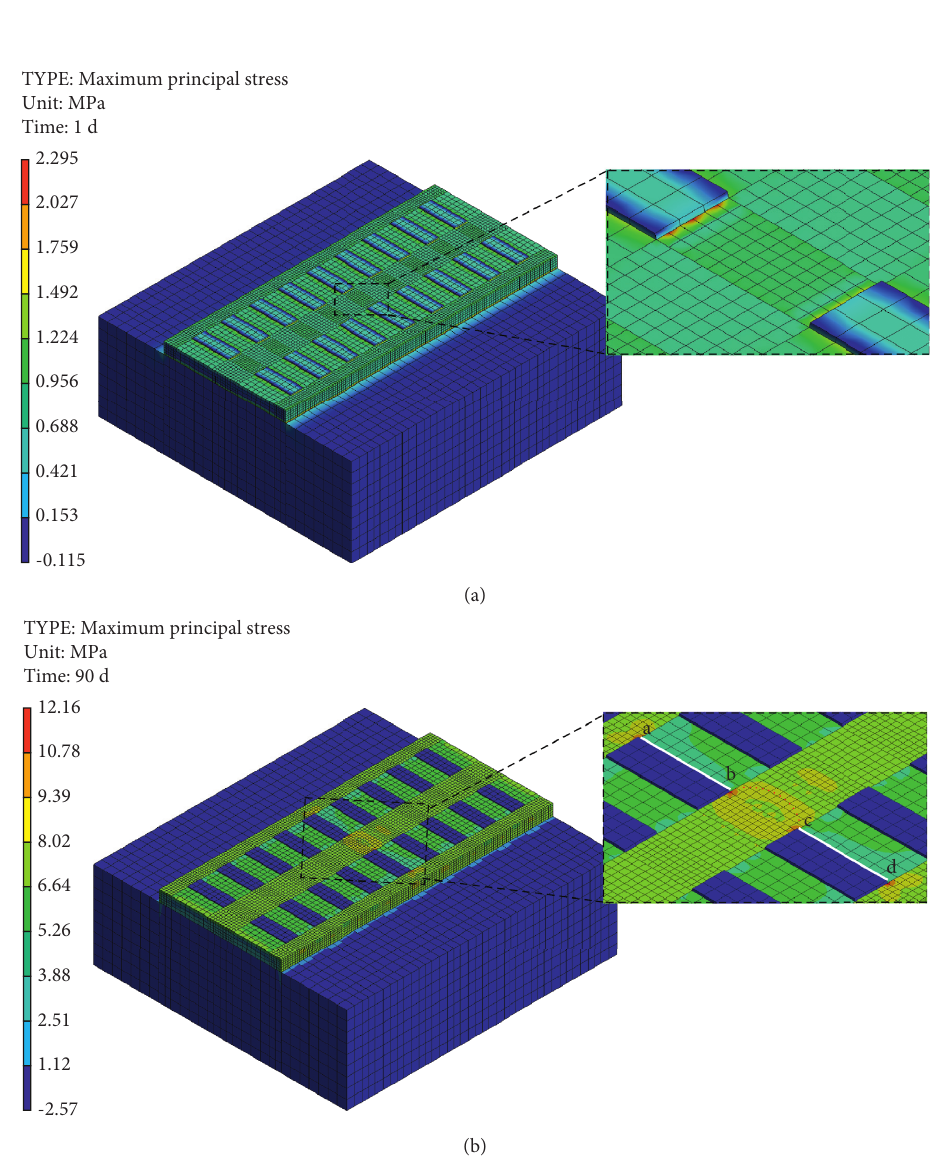
Figure 20: Maximum principal stress contour of ballastless track. (a) t � 1 d and (b) t �